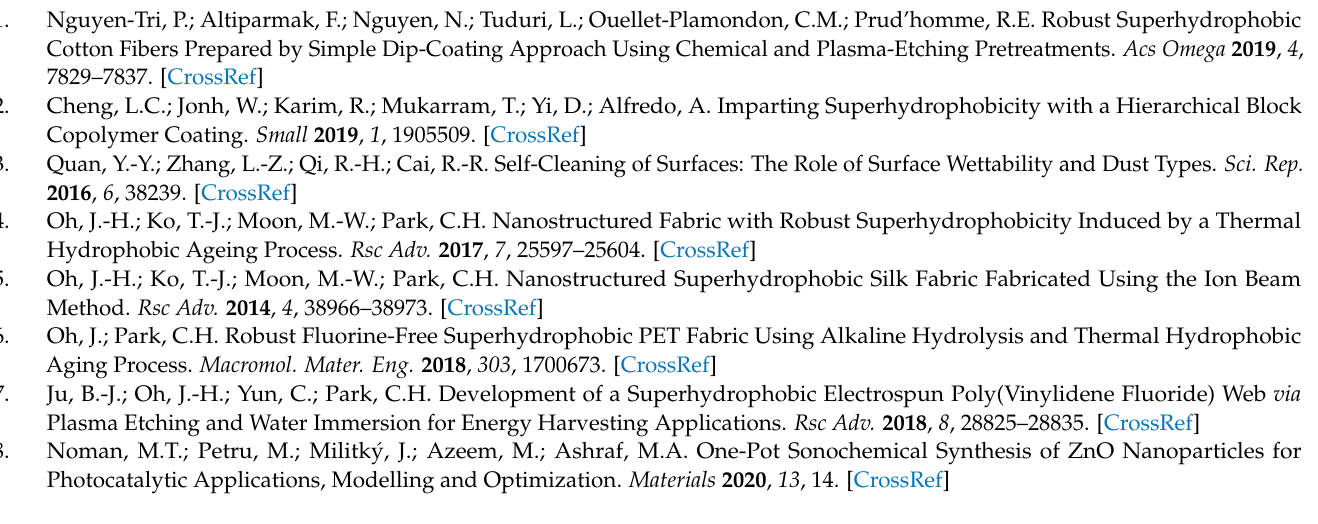
and with silicon carbides, Table S7: Measurement of the rolling distance of water droplets on the 314D fabrics contaminated without and with silicon carbides, Table S8: Measurement of the rolling distance of water droplets on the 475D fabrics contaminated without and with silicon